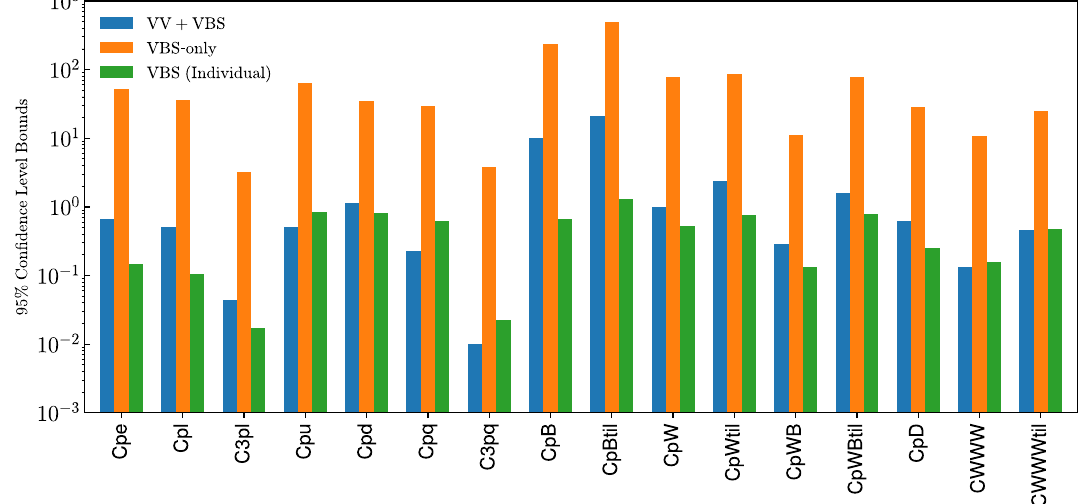
Fig. 24 Comparison of the 95% CL intervals in the baseline fit with those resulting from marginalised and individual VBS-only fits. Only the unfolded VBS cross-section measurements listed in Table 5 are being included in the